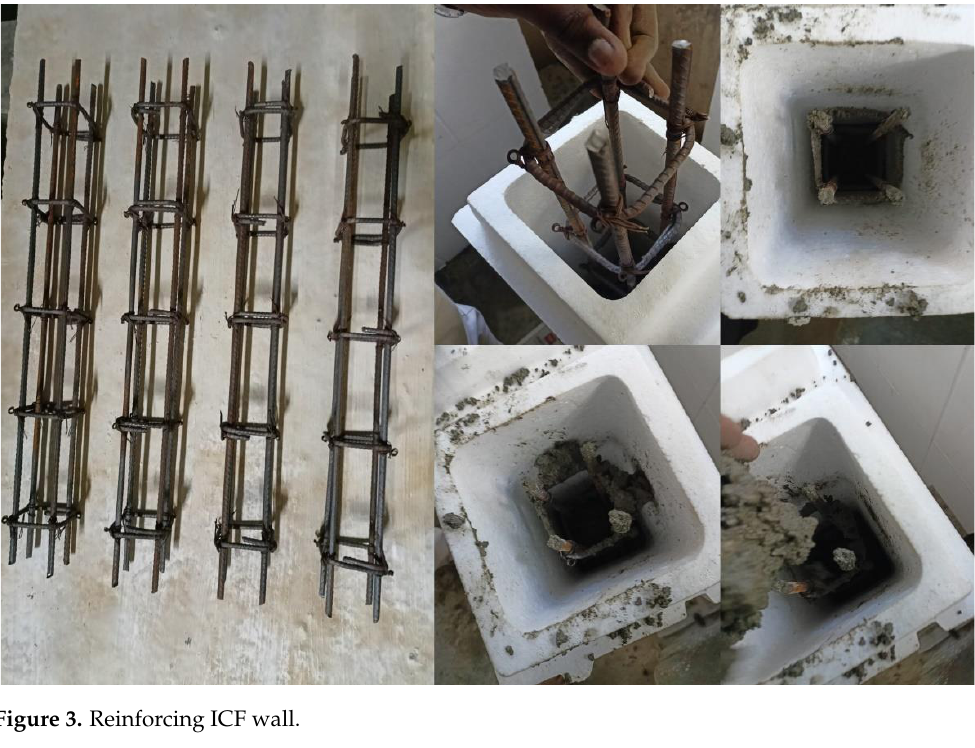
Figure 3. Reinforcing ICF wall.